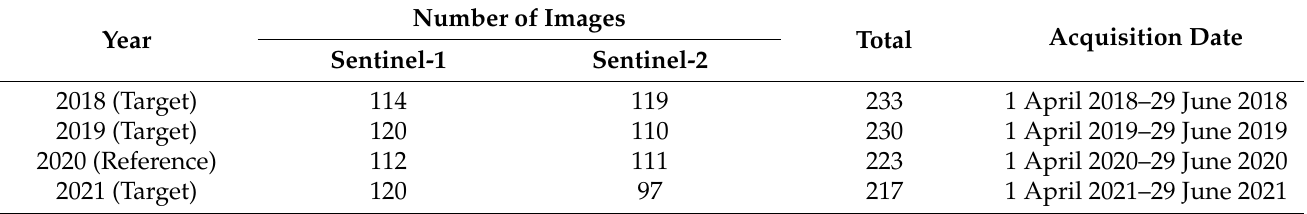
Table 2. The number of images and acquisition dates of Sentinel-1 and Sentinel-2 time